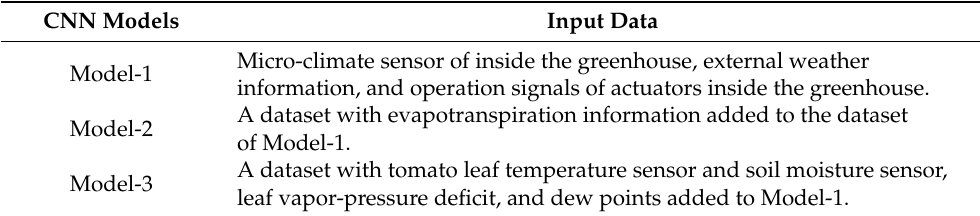
Table 3. The datasets used for the humidity prediction